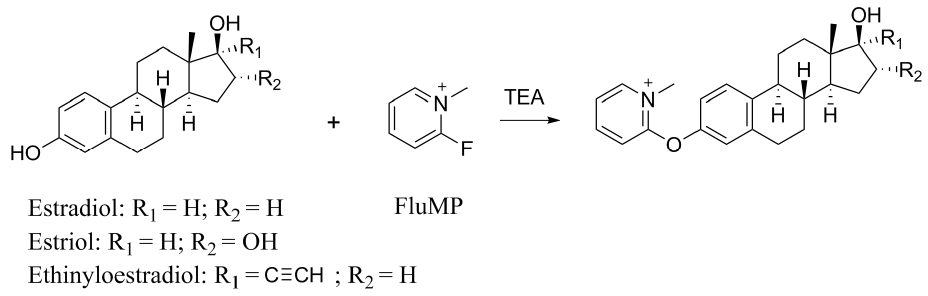
Figure 1. Derivative reaction of FluMP and estrogens.